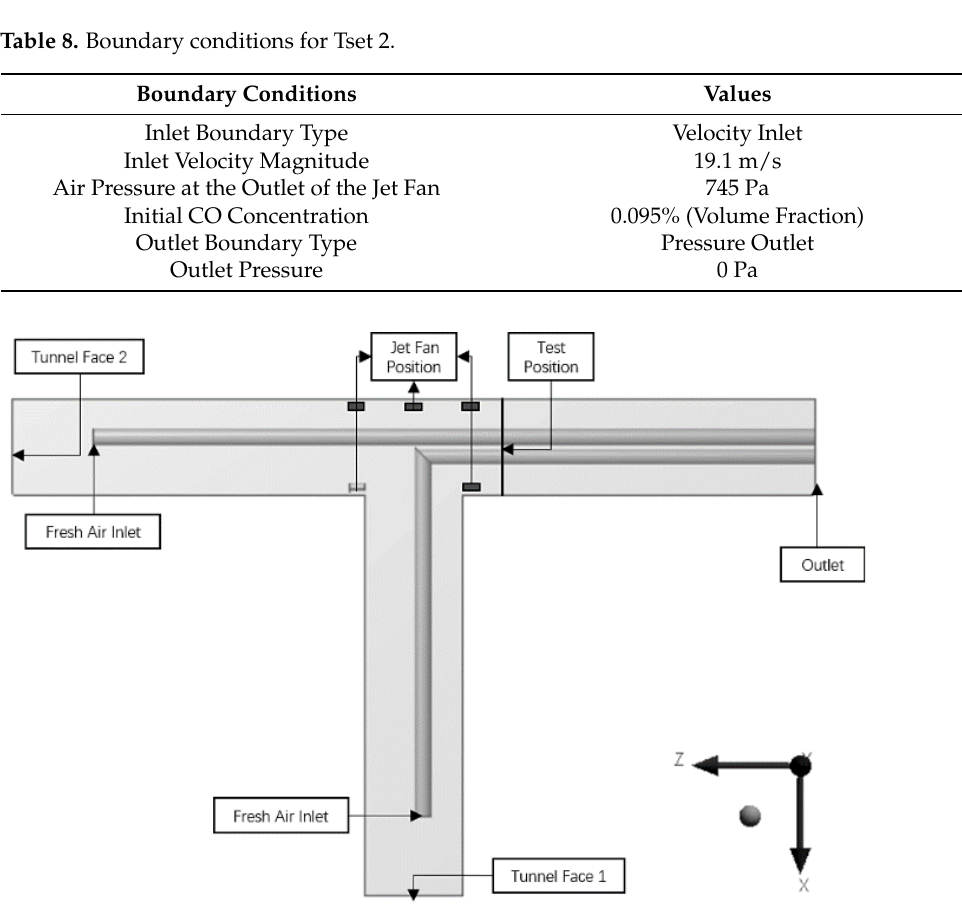
Figure 6. Positions of the jet fans. Table 7. Settings of model parameters for Tset 2.